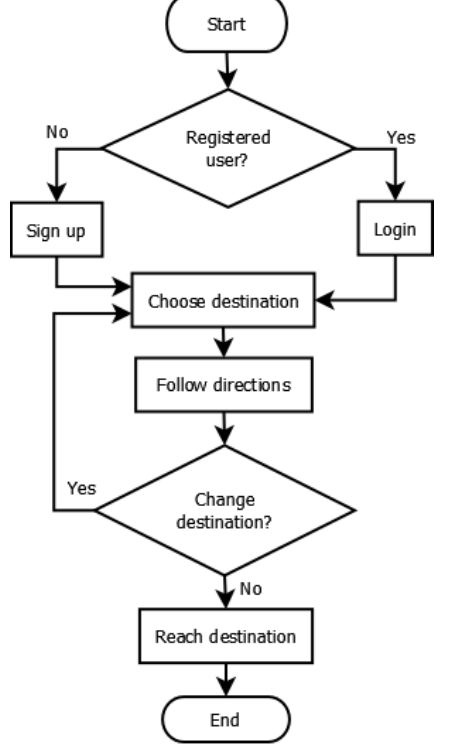
Figure 2. Flowchart of